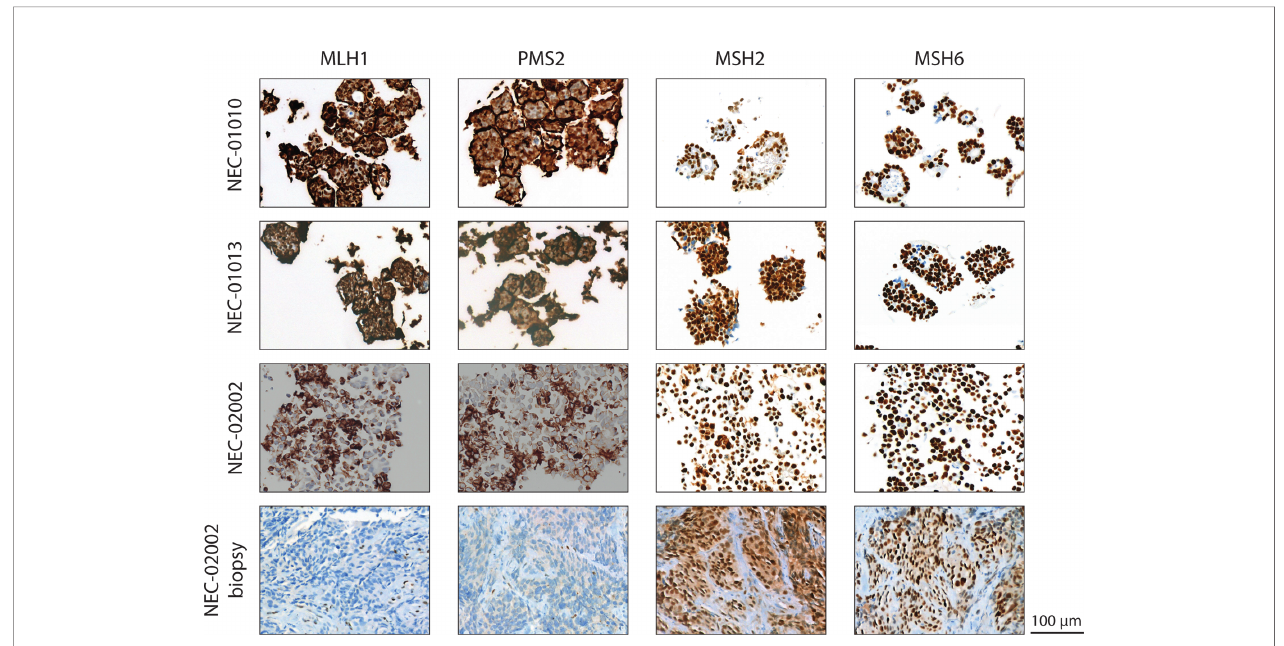
FIGURE 2 | Mismatch repair status of GEP-NEC organoid lines. Staining of slides from NEC-01010 (P7 and P11), NEC-01013 (P13), and NEC-02002 organoids (P15), as well as the original tumor of NEC-02002, for mismatch repair proteins MLH1, PMS2, MSH2, and MSH6. Note 100% nuclear expression of MHS2 and MSH6 but absence of nuclear staining of MLH1 and PMS2 in both organoids and original tumor of NEC-02002. The brown halo on the cell border is a speci fi c staining caused by residual Geltrex in organoid slides. Scale bar = 100 µm.